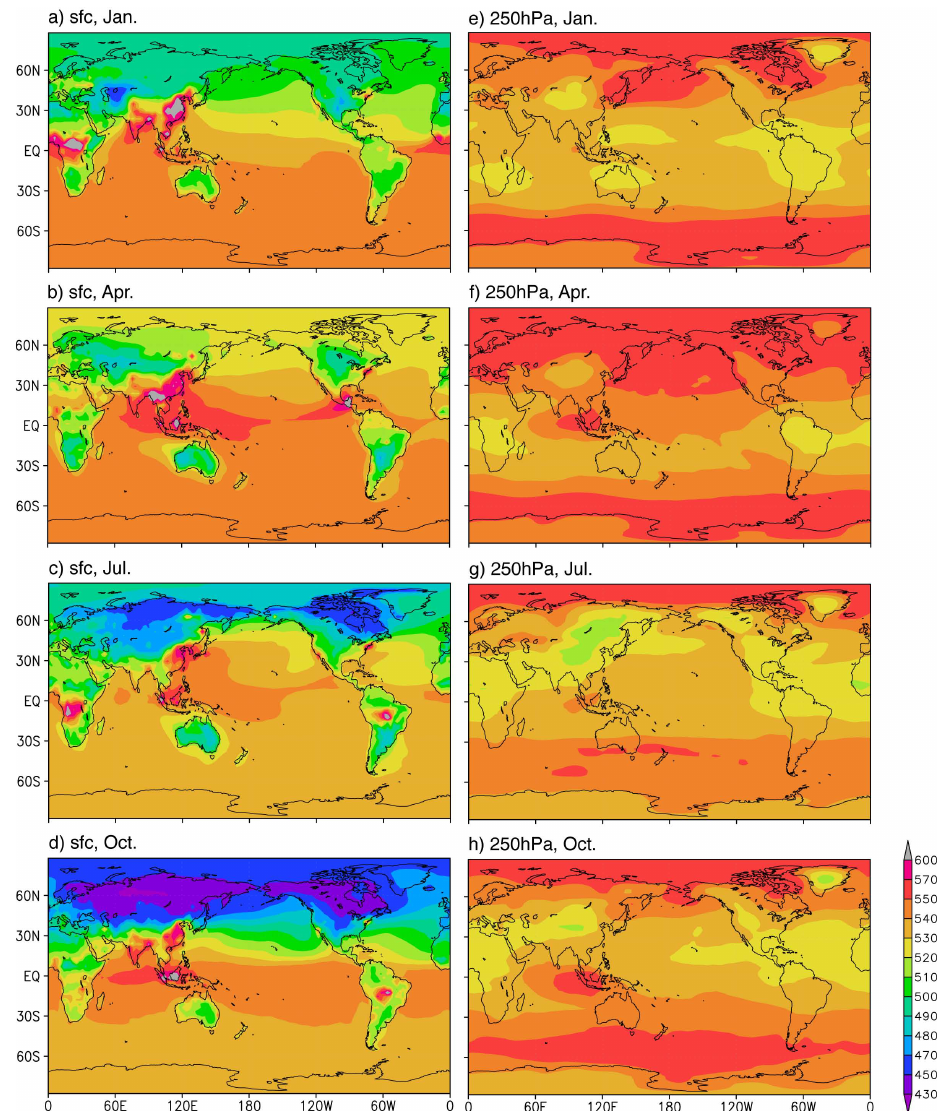
Fig. 6. Distribution of H 2 mixing ratio (ppb) calculated at the surface (left panel) and 250hPa (right panel) for January ( a , e ), April ( b , f ), July ( c , g ), October ( d , h ). The values are averaged over the period of